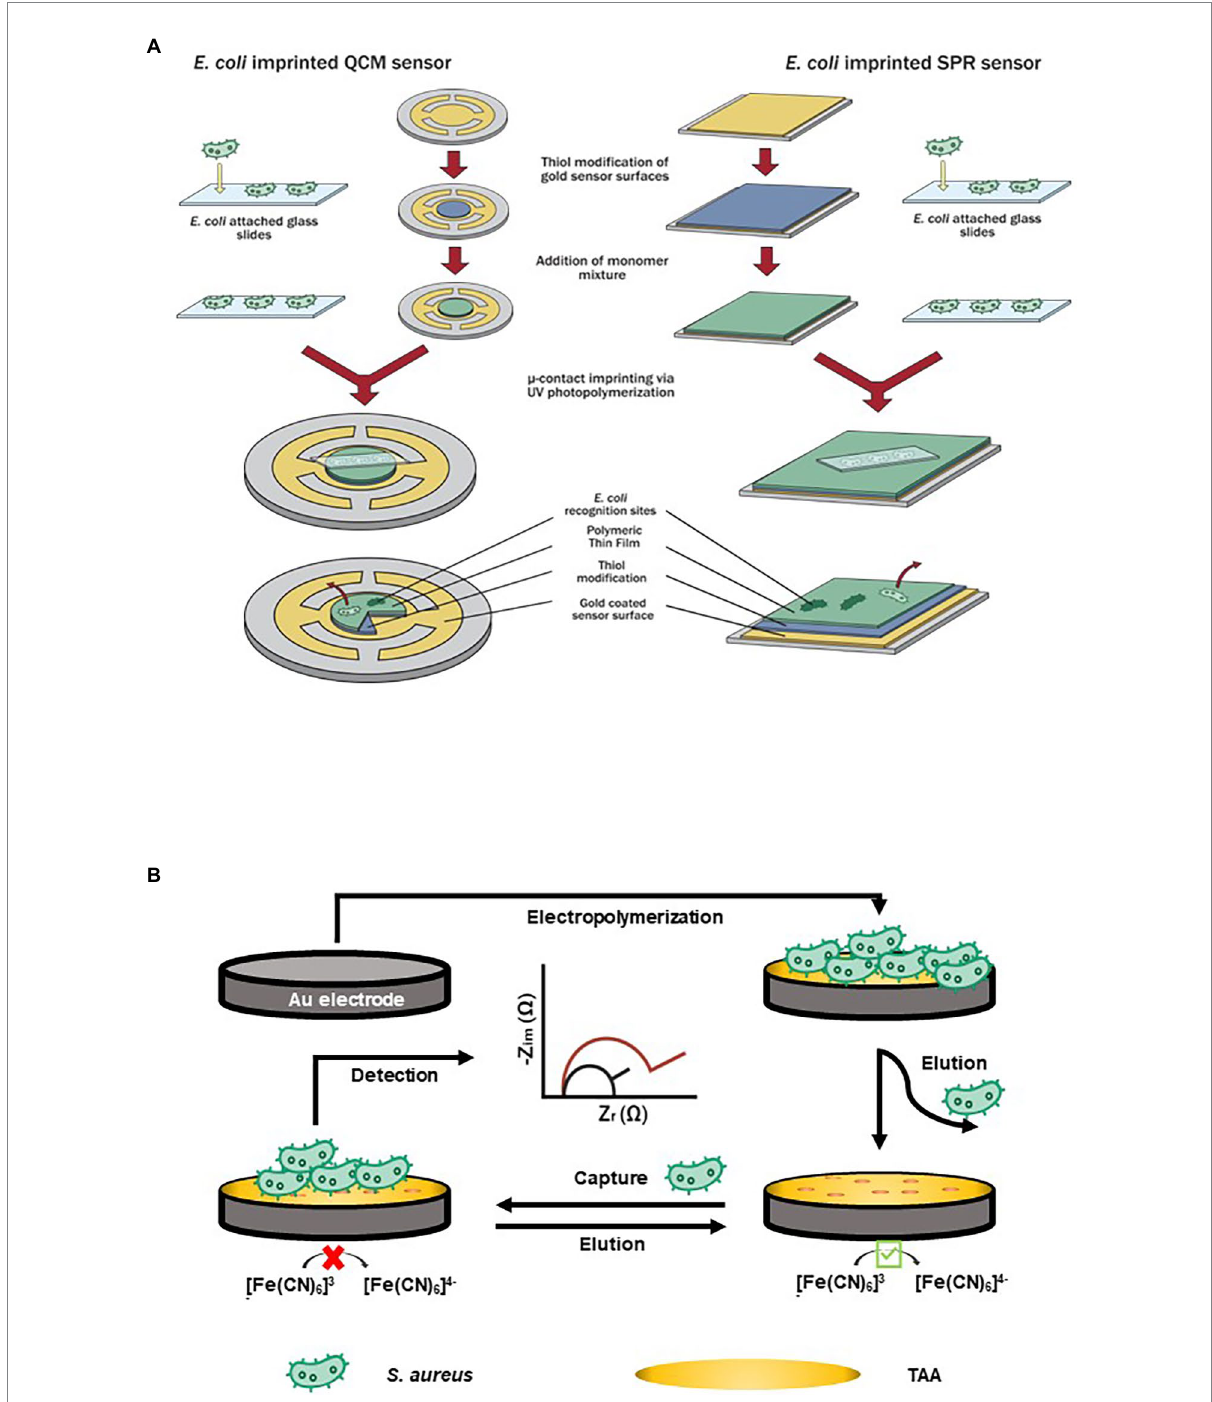
FIGURE 2 Examples of amino acid-based biosensors. (A) Schematic representation of microcontact imprinting. Microcontact imprinting of E. coli on QCM and SPR sensor surfaces. Image adapted from Yilmaz et al. (2015), and (B) Impedimetric sensor based on bacteria-imprinted conductive poly(3- thiopheneacetic acid; BICP) film for the rapid detection of S. aureus (Wang et al.,